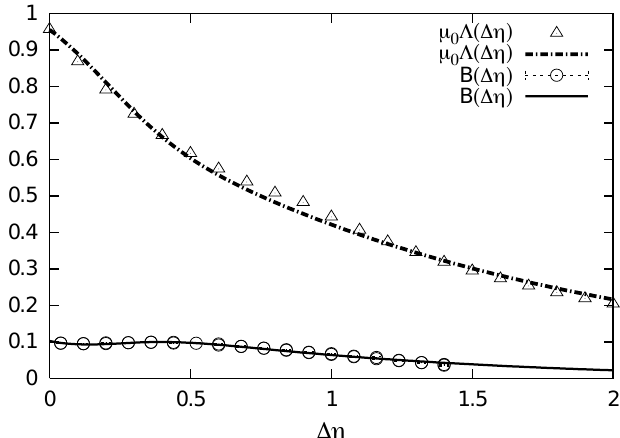
Figure 1. The results of simultaneous fitting (lines) by Formulas (11) and (34) of the string two-particle correlation function µ 0 Λ ( ∆ η ) − (cid:77) , extracted in [14] from the ALICE data [13] on the FB correlations (see Section 3), and the balance function B ( ∆ η ) - ◦ , measured by ALICE [15] in pp collisions at 7